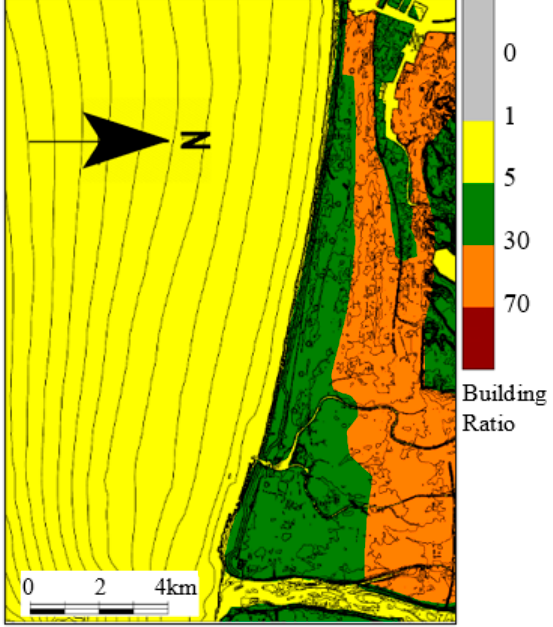
Figure 12. Building ratio in a calculation mesh (the area ratio of buildings and trees in a mesh).